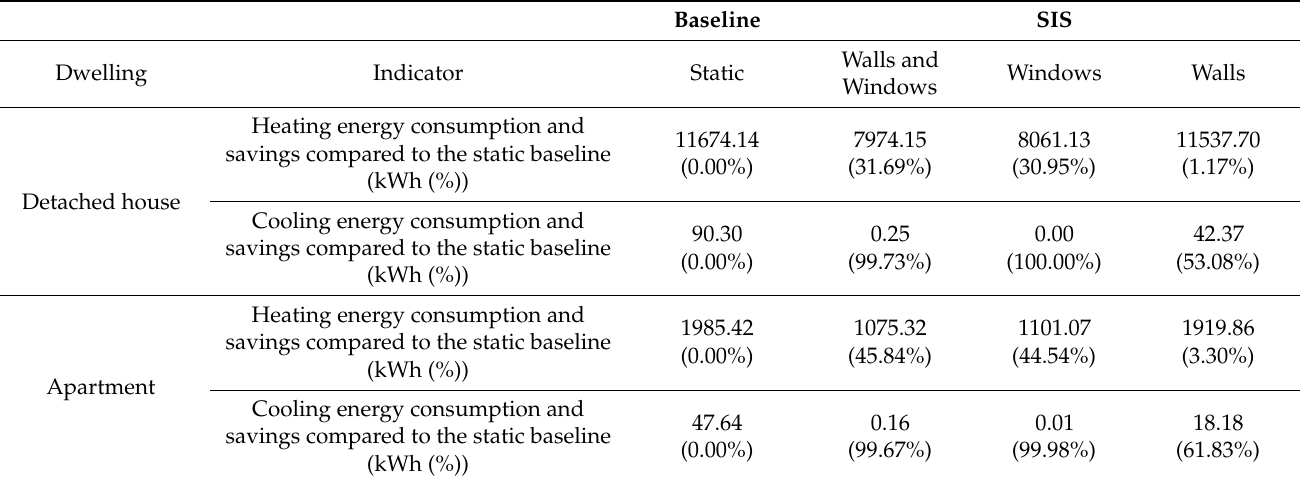
Table 8. Comparison of heating and cooling energy consumption for static and SIS windows and walls for the prototypical detached house and